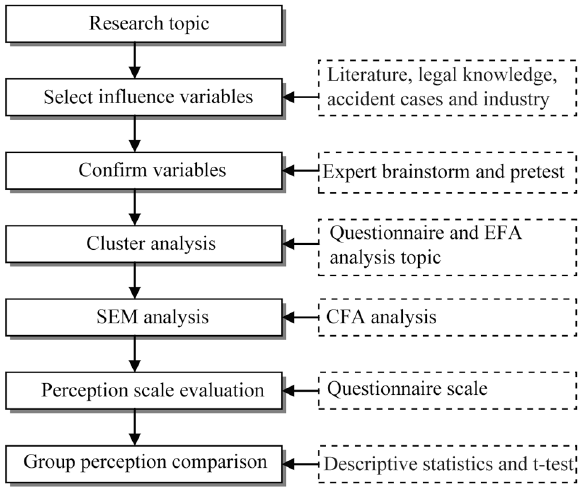
Fig. 1. Procedure and applied methods of perception